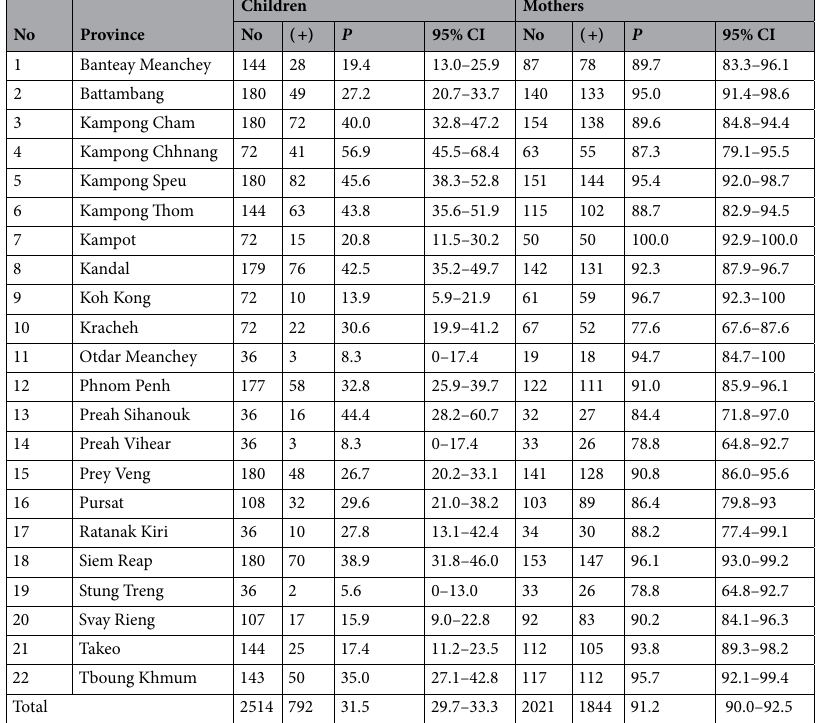
Table 1. Area-specific prevalence of total anti-HAV among children and their mothers in Cambodia.